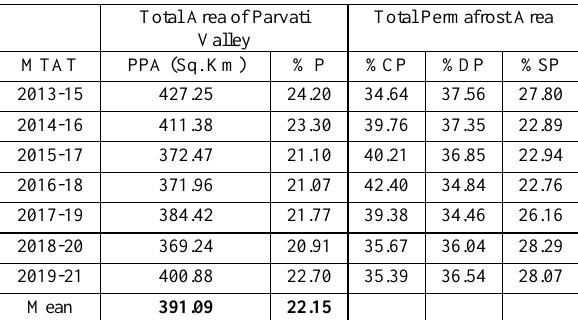
Table 2: The table summarizing the total (PPA) probable permafrost area (in Sq. Km and %) and the percentage of permafrost area in different categories (CP, DP, SP) using MTAT for each consecutive years starting from 2013 to 2021.